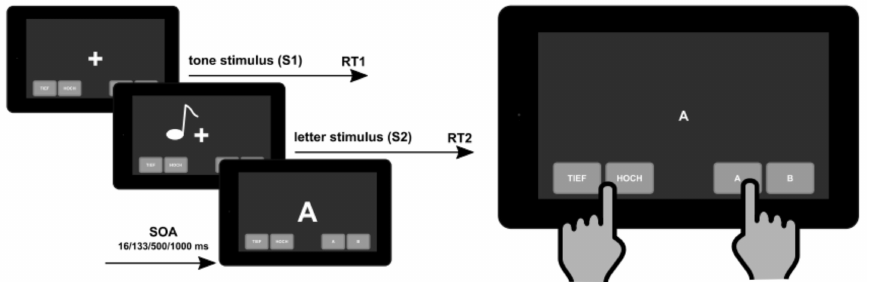
Figure 2. Illustration of the psychological refractory period paradigm as a dual-task assessment in MS. Stimulus 1 (tone) is always presented first, followed by stimulus 2 (letter) in a defined stimulus-onset asynchrony (SOA). PwMS are advised to respond first to stimulus 1 and as quickly as possible to stimulus 2 by pressing defined keys. RT: reaction time